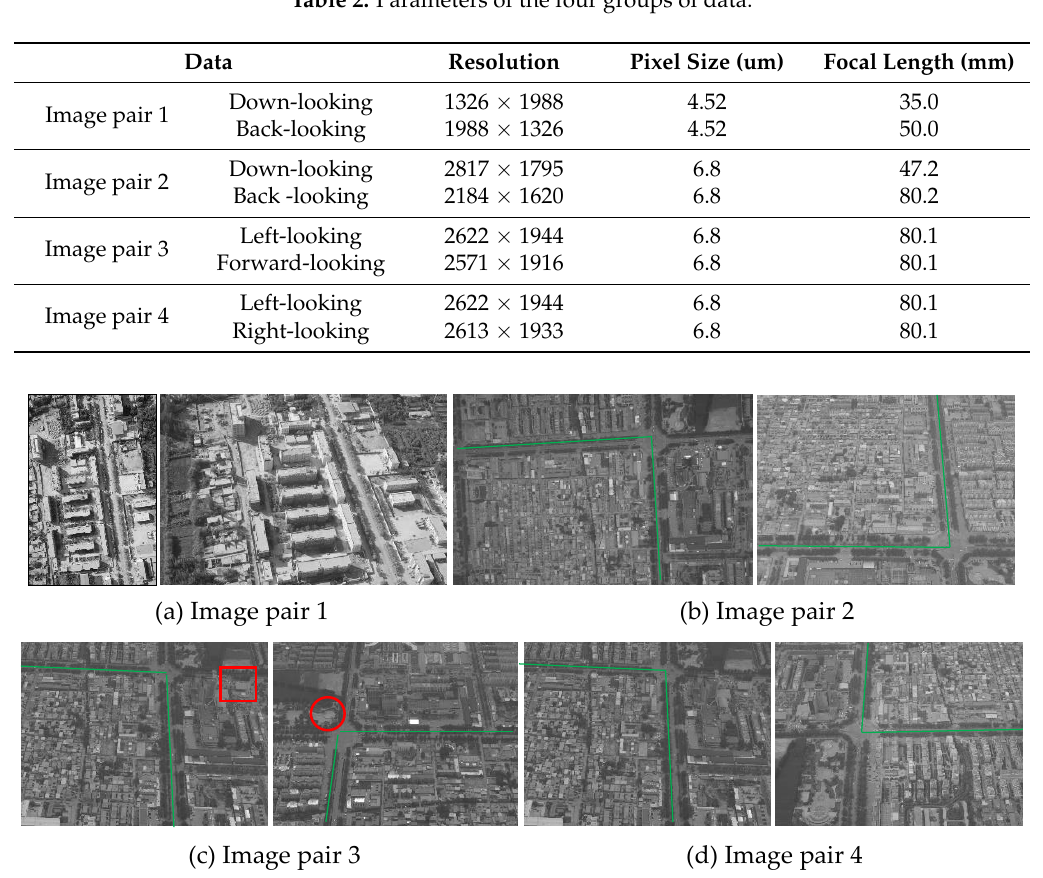
Figure 7. Four pairs of original images. ( a ) Image pair 1; ( b ) Image pair 2; ( c ) Image pair 3; ( d ) Image pair 4. The red rectangle indicates a rectanglar building and the red circle indicates a round object, respectively, on the original images. The quadrilateral areas formed by green lines and the image boundary are flat areas and outer areas are fluctuant areas.